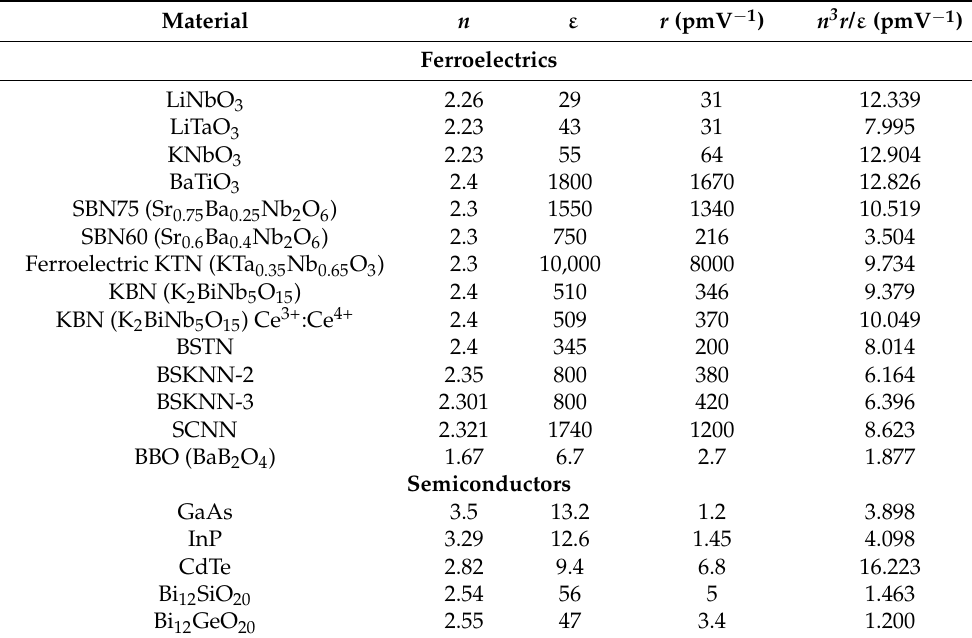
Table 1. The properties of some materials with linear electro-optic (EO)